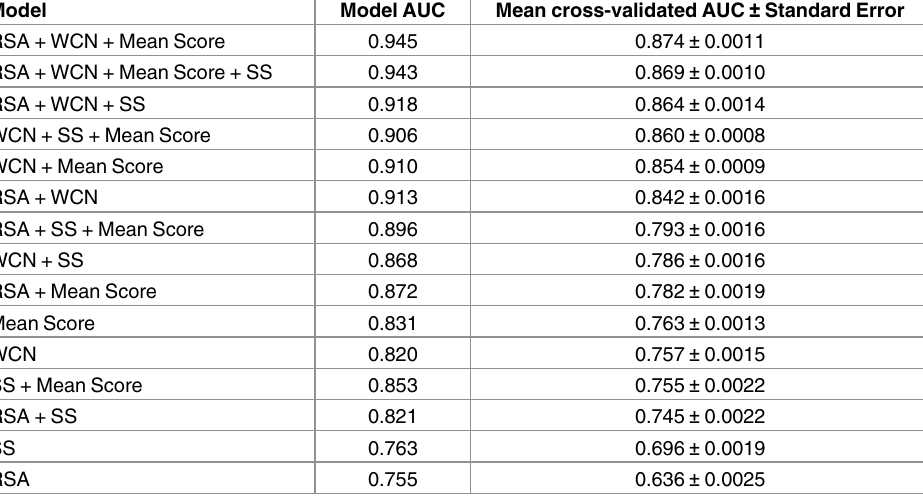
Table 2. Summary of AUC values for models using a Support Vector Machine (SVM). The structural propertiesanalyzedare RSA, WCN, secondary structure (SS), and mean score. Model AUC indicatesthe AUC resulting from the entire dataset, and mean cross-validated AUC indicatesthe averaged AUC calculated from repeated10-fold cross-validation. Models are sorted in order of descending cross-validated